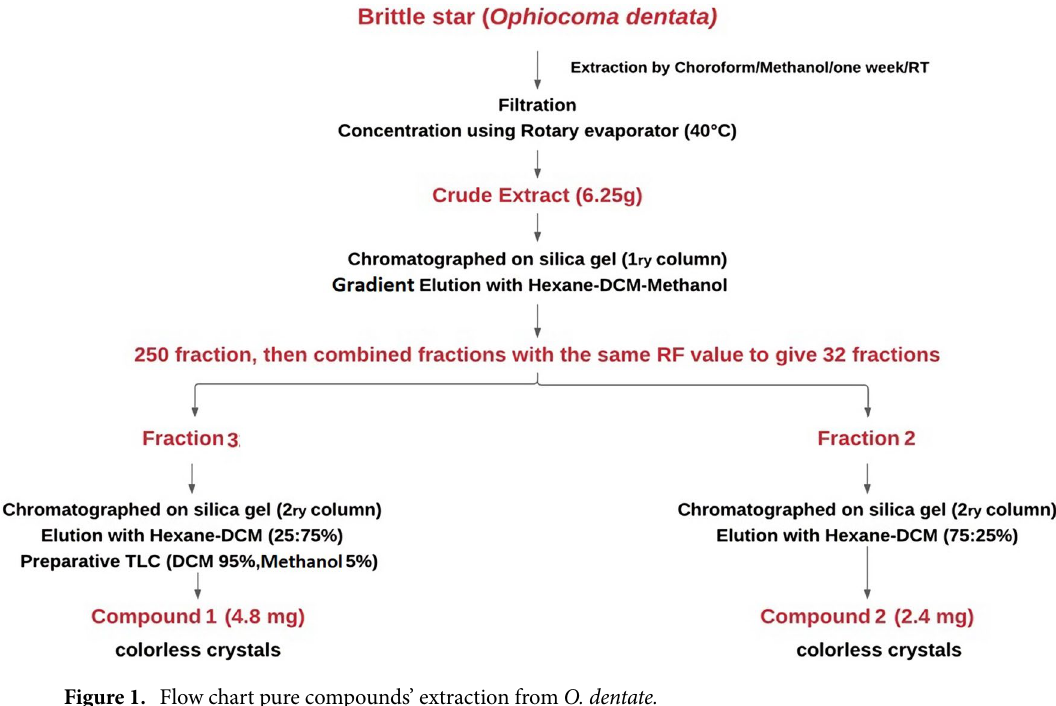
Figure 1. Flow chart pure compounds’ extraction from O. dentate.